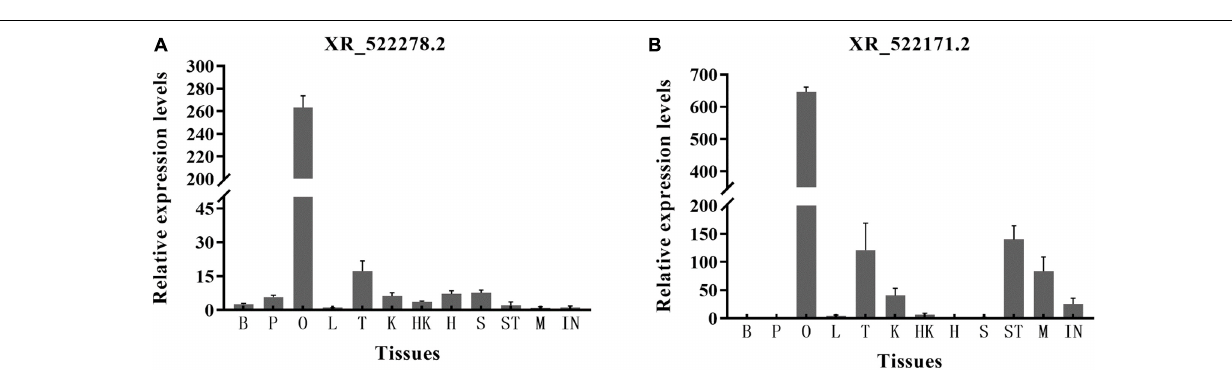
this study, we identified 1,059 and 312 DE mRNAs in stage IV vs. V and V vs. VI, and total of 58 and 187 DE lncRNAs were observed in stage IV vs. V and V vs. VI,